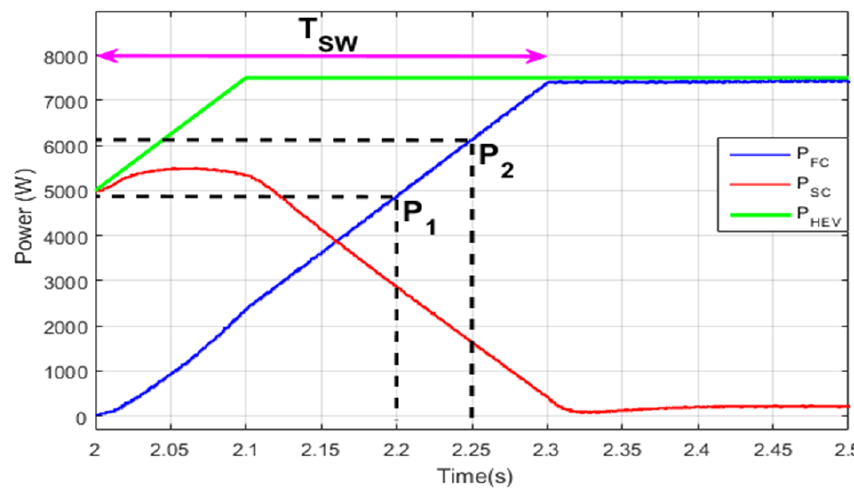
Figure 19. Linear-based power source switching.